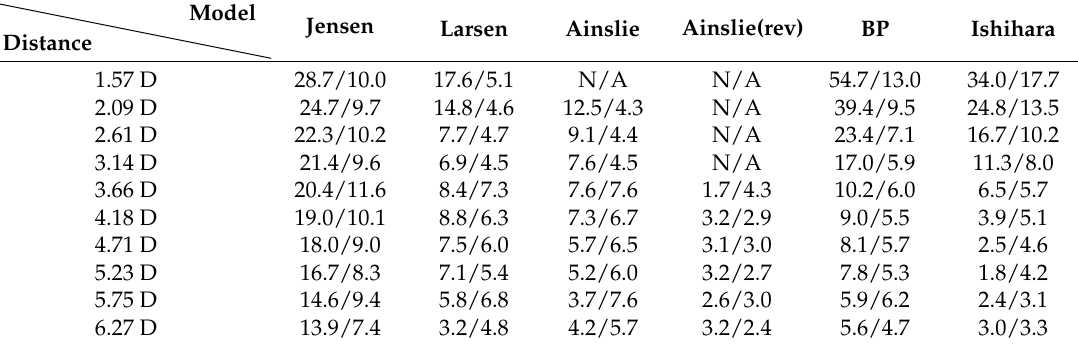
Table 4. Wind speed mean deficit root mean square error (RMSE) comparison include modified Ainslie eddy viscosity wake model: Below rated error (%)/Above rated error